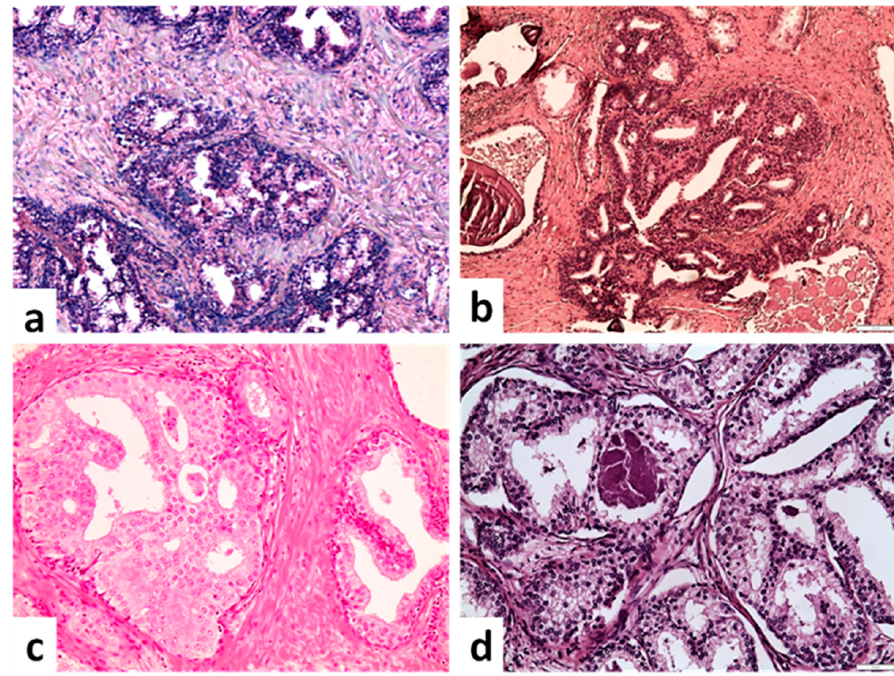
Figure 1. Benign cribriform formations. ( a ) Glands in the base of the prostate with luminal tufting (upper part) and nuclear pseudostratification. A cribriform architectural pattern is observed, but lack of cytologic atypia and presence of basal cell layer excludes malignancy (×100). ( b ) Basal cell hyperplasia with a cribriform pattern (×100). ( c ) Hyperplastic cribriform gland lacking cytologic atypia and displaying abundant pale to clear cytoplasm similar to acinar cells of adjacent prostatic gland (right side) (×200). ( d ) Clear cell cribriform hyperplasia with bland monotonous nuclei (×200) (scale bar is 50 μ m).